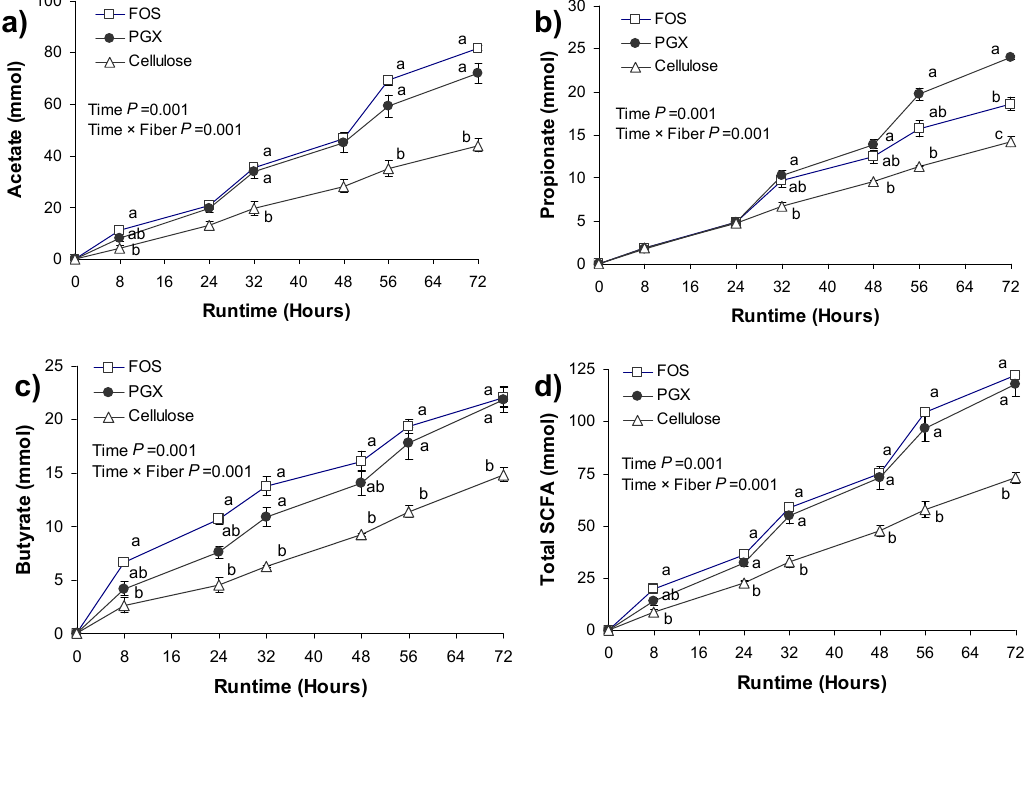
Figure 2. The average cumulative production of ( a ) acetate, ( b ) propionate, ( c ) butyrate and ( d ) total short chain fatty acids (SCFA) in TIM-2, during 72 h on the fructooligosaccharide (FOS), PolyGlycopleX (PGX), or cellulose substrate. Values are mean ± SEM ( n = 2 for FOS and cellulose and n = 3 for PGX). Labeled means without a common letter at the same time point differ, p < 0.05. Y -axis scales differ across